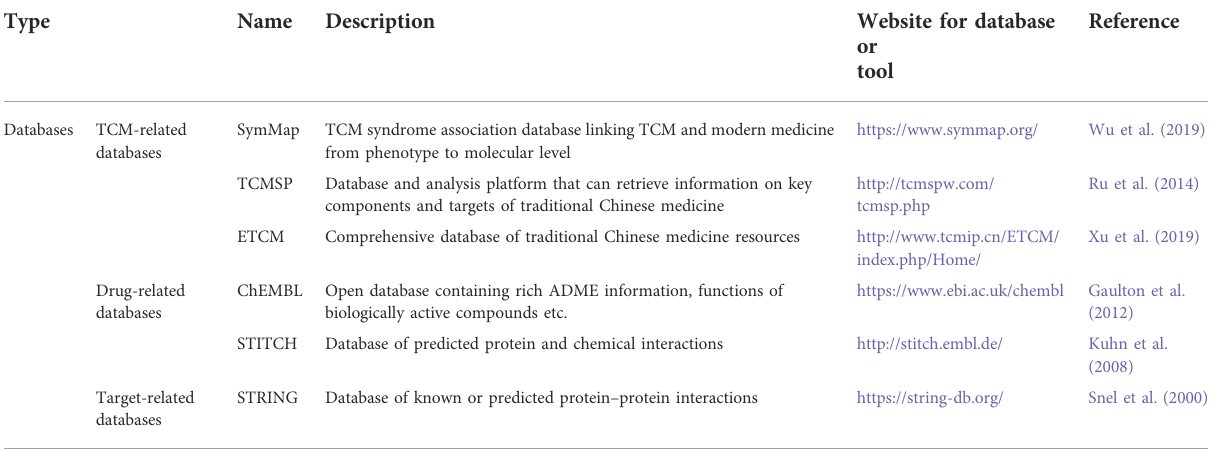
TABLE 1 Public databases related to TCM network